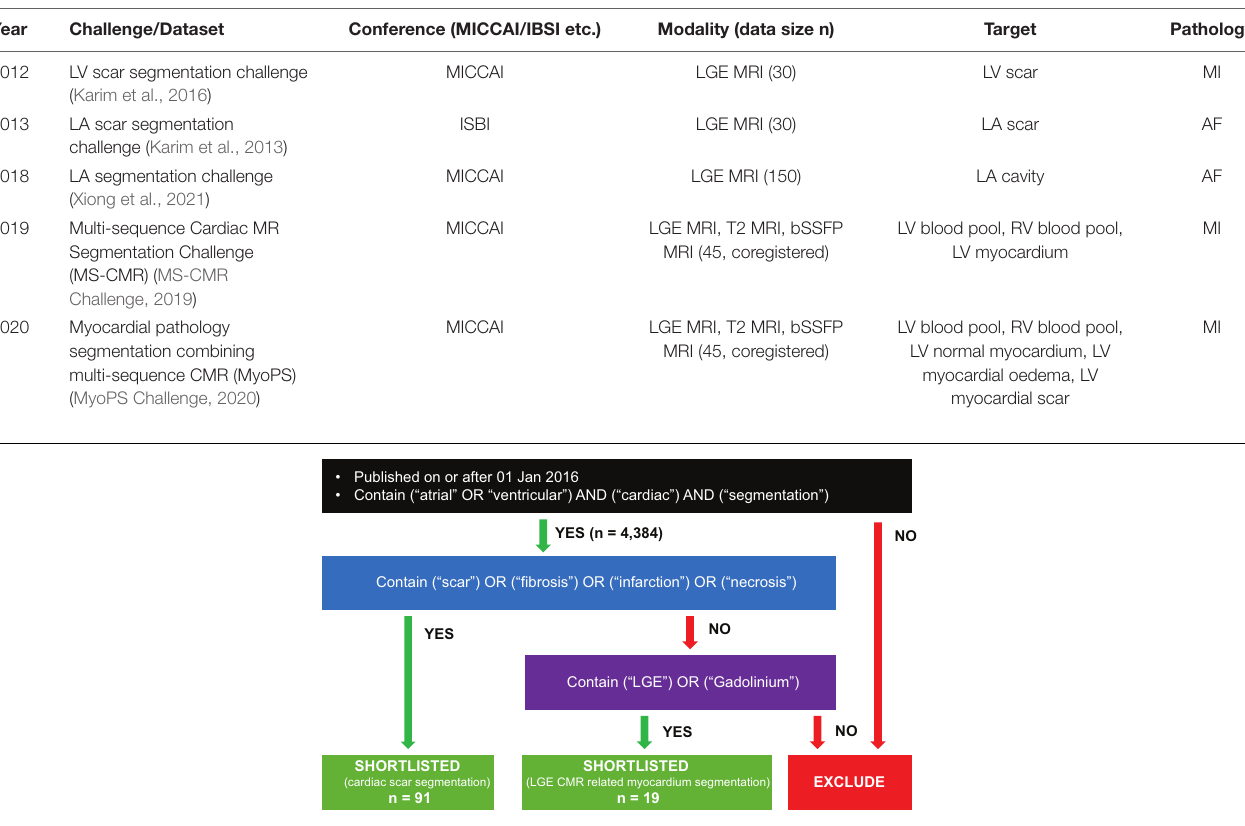
TABLE 1 | List of challenges in segmentation of LV and LA anatomy and scar in LGE CMR.